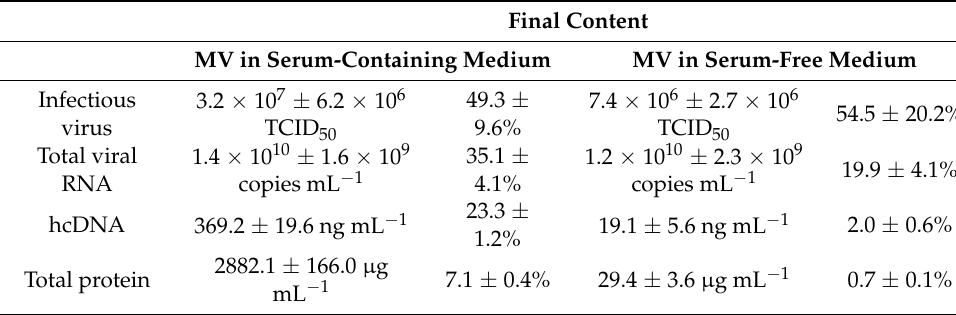
Table 4. Overview of the MV and impurity contents of the final fraction. The MV suspensions in serum-containing and serum-free medium were concentrated (factor of 8) by UF/DF with a buffer exchange of five diavolumes. Data are means ± SEM (n = 5). Each run was evaluated separately and the data were combined to determine the overall recovery